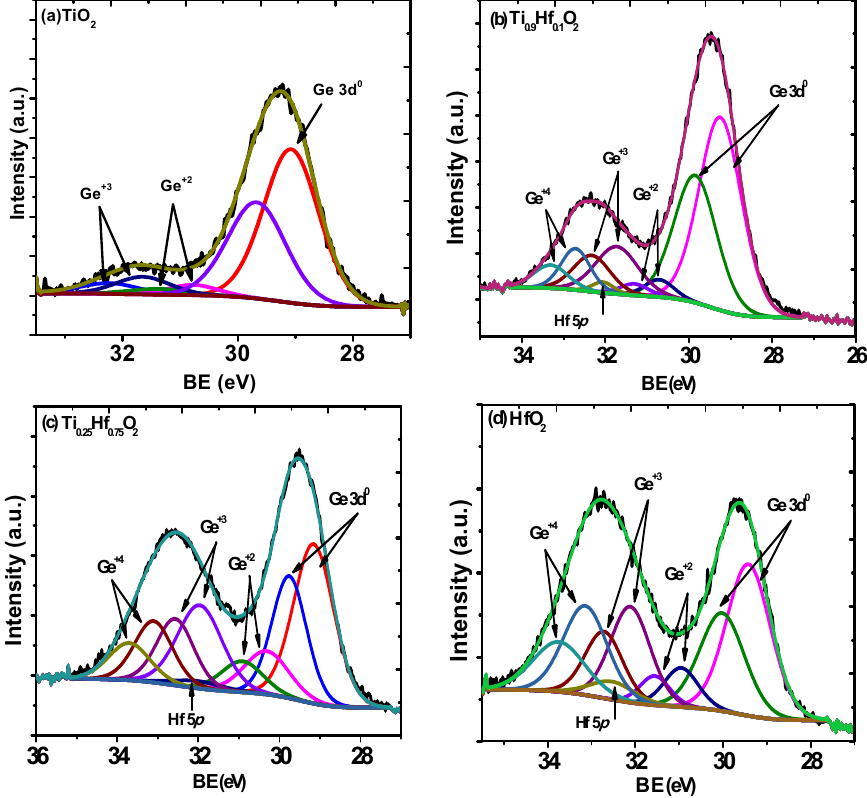
Figure 4. Ge 3 d spectra from 5 nm thin films of: ( a ) TiO 2 ; ( b ) Ti 0.9 Hf 0.1 O 2 ; ( c ) Ti 0.25 Hf 0.75 O 2 ; and ( d ) HfO 2 samples. The presence of Ge +2 , Ge +3 , and Ge +4 is due to the Ge oxidation at the interfacial region. There is an increment of GeO x peak intensity, especially for Ge +4 peaks, with the increase of the HfO 2 concentration.